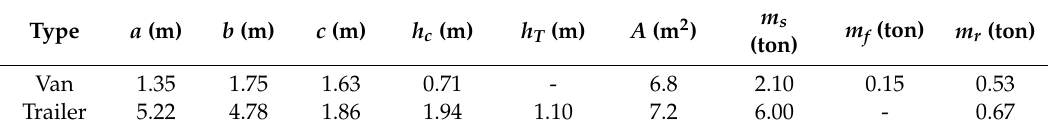
Figure 5. Aerodynamic coefficients according to wind direction for: ( a ) van and ( b ) tractor-trailer. Table 1. Dimensions and parameters of vehicle models.